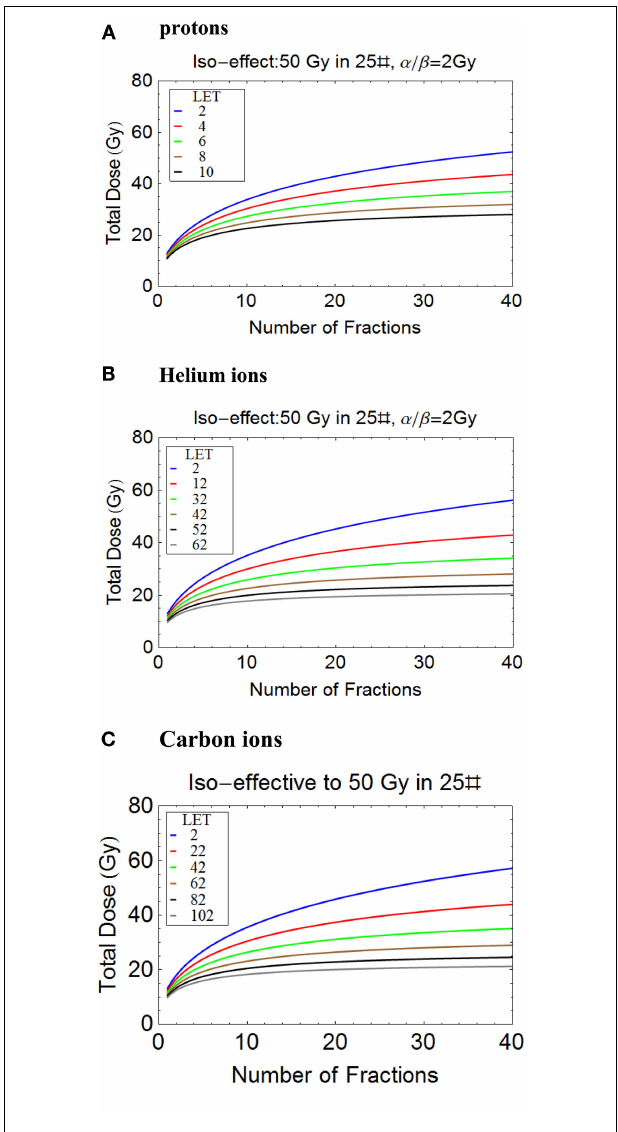
FIGURE 8 | (A-C) Plots of total iso-effective dose versus number of fractions for the given iso-effect and α / β ratio. (A) Protons, (B) Helium ions, (C) Carbon